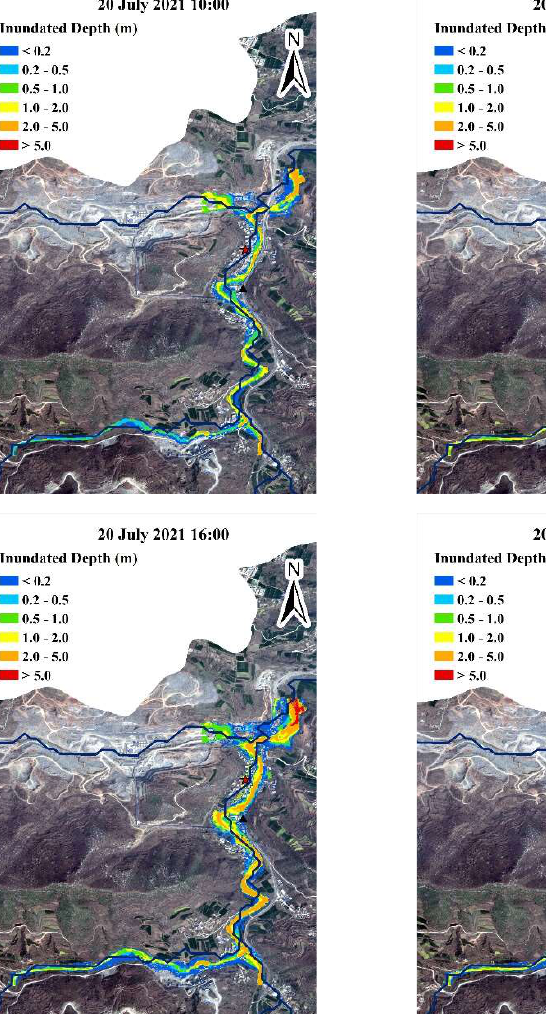
Figure 10. Submerged water depth of rivers at different